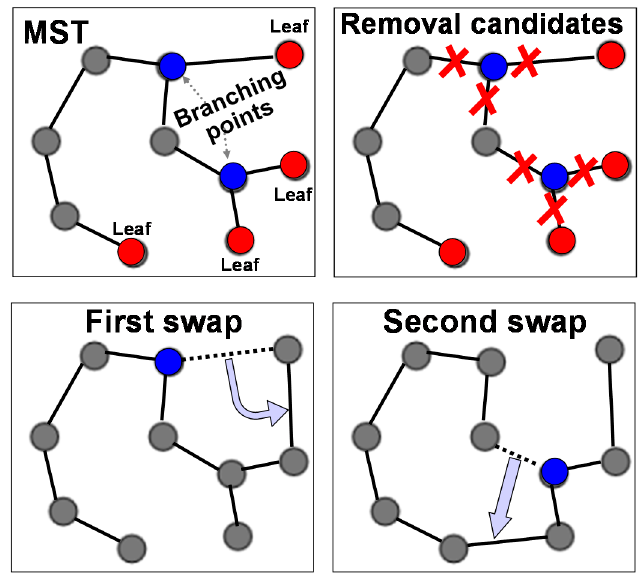
Figure 2. Idea of the MST-to-TSP algorithm. Branching points and the attached links are first detected. At every step, one of these links is removed and the separated trees are merged by connecting two selected leaf nodes. In this example, two steps are needed to reach the solution of the open-loop TSP.